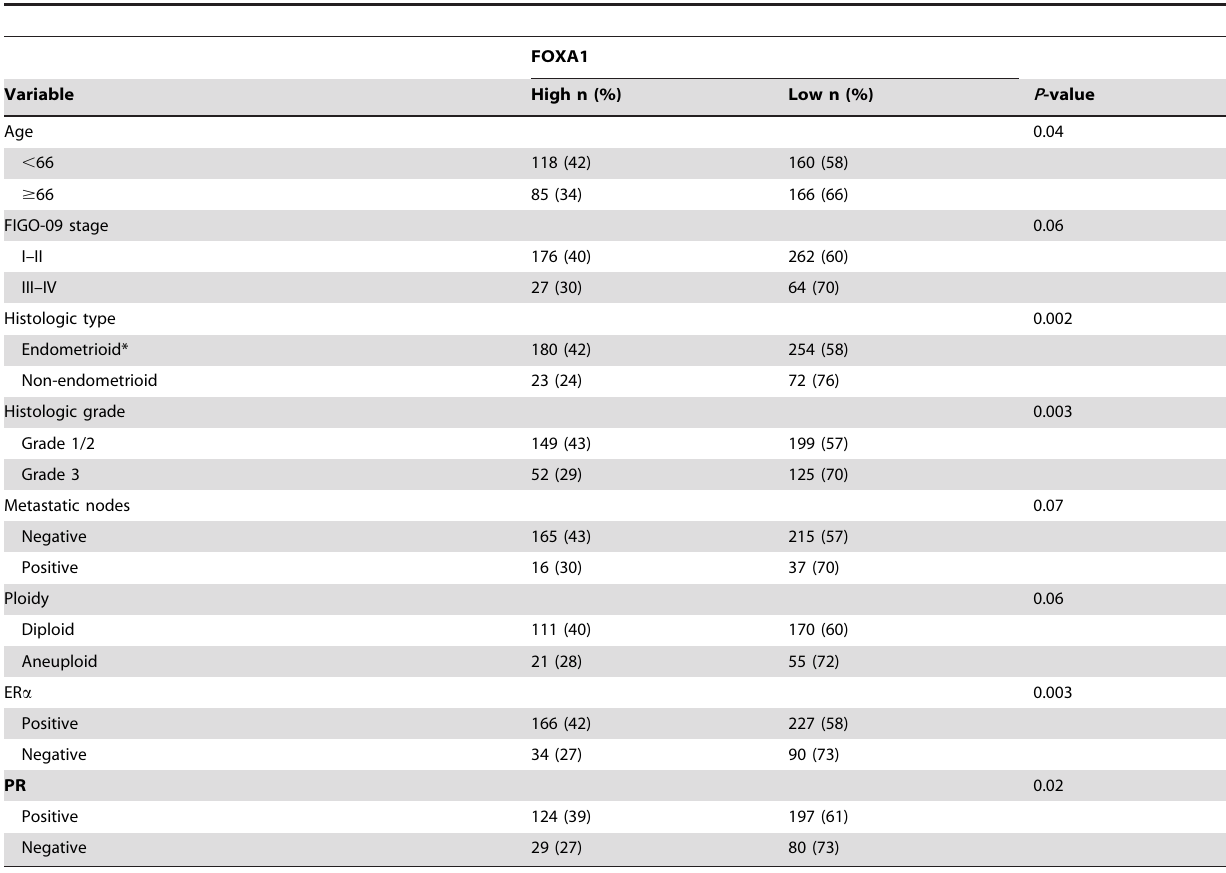
Table 1. FOXA1 protein expression in 529 patients with endometrial carcinoma related to clinicopathologic variables